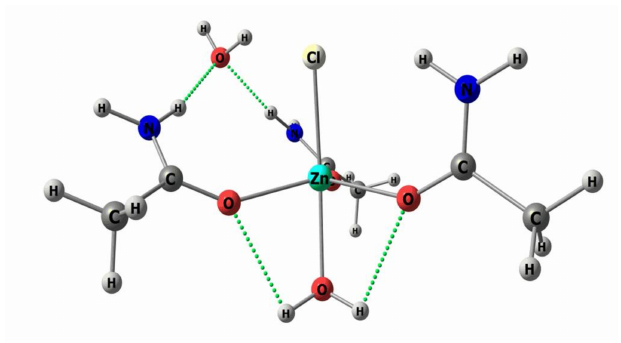
Figure 8. Scheme of DES and water